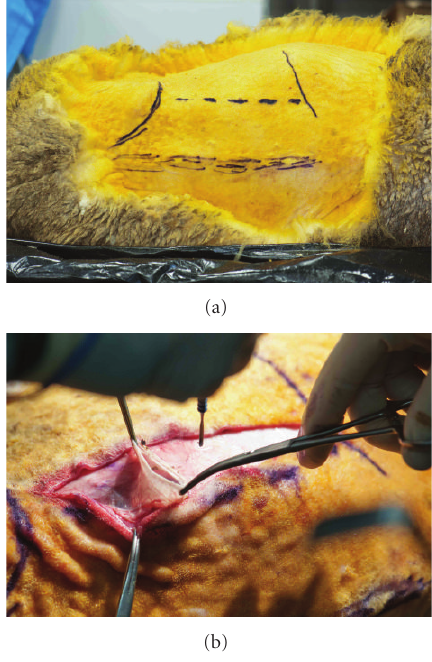
Figure 3: (a) Preoperative photo of sheep in right lateral position demonstrating lumbar spinous processes (lower dashed line), left lumbar transverse processes (upper dashed line), iliac crest (left), and costal margin (right). (b) Longitudinal incision made parallel to and 1cm anterior to transverse processes. Lateral aspect of abdominal wall fascia and musculature partially opened.